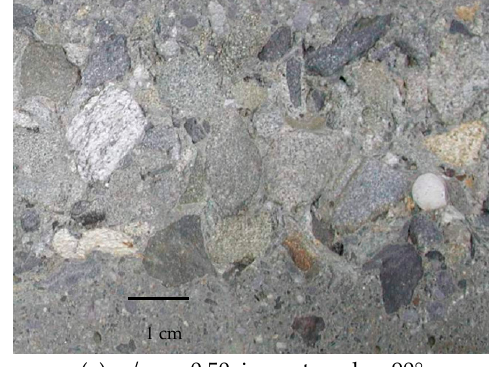
Figure 4. Typical abrasion site in steel fiber concrete abraded by friction abrasive action (w/cm = 0.36, ASTM